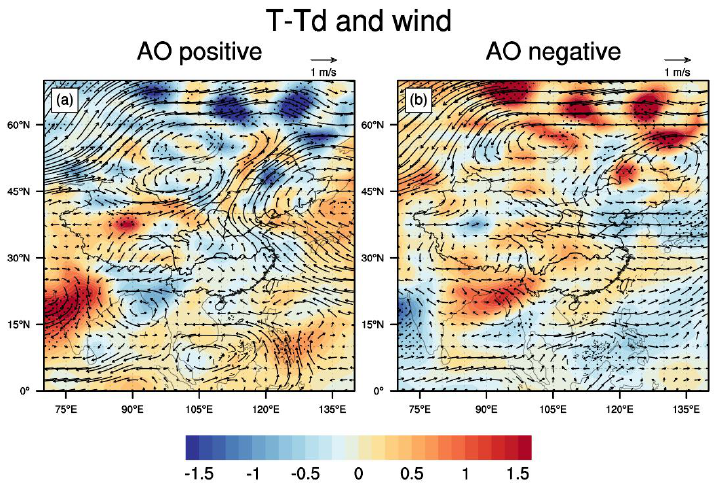
Figure 8. The same as Figure 5, but for the wind and T-Td (shaded) anomaly fields at 850 hPa (unit: m/s). Dots represent the values above the 90% confidence level.